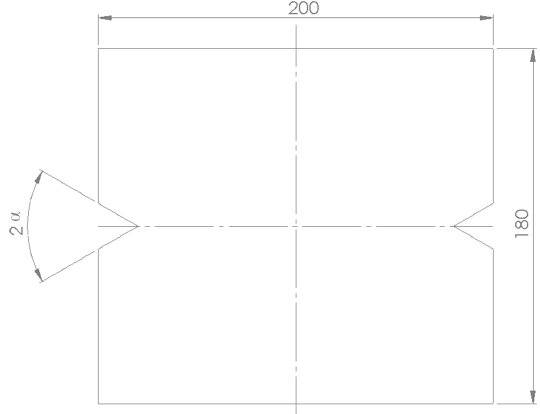
Figure 1: 2D geometry with a variable angle, size in